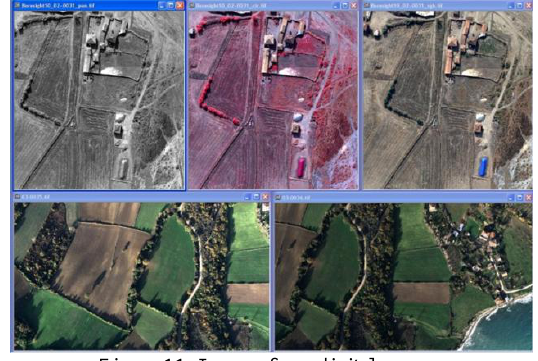
Figure 11. Images from digital camera